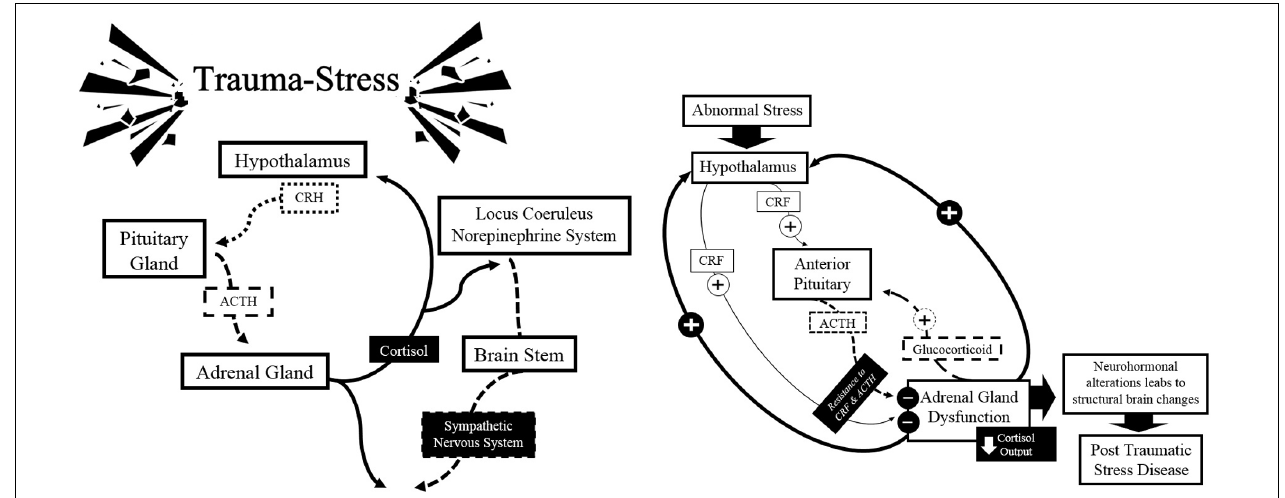
FIGURE 4 | Schematic summary of the classical model of neurobiology in the expression of PTSD: hypothalamic-pituitary-adrenal axis. Source: made by